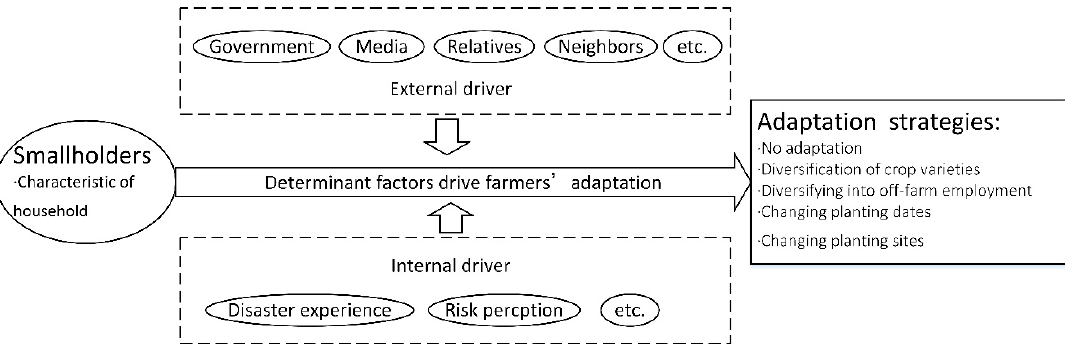
Figure 1. Diagram of the influence mechanisms of farmers’ adaptation .